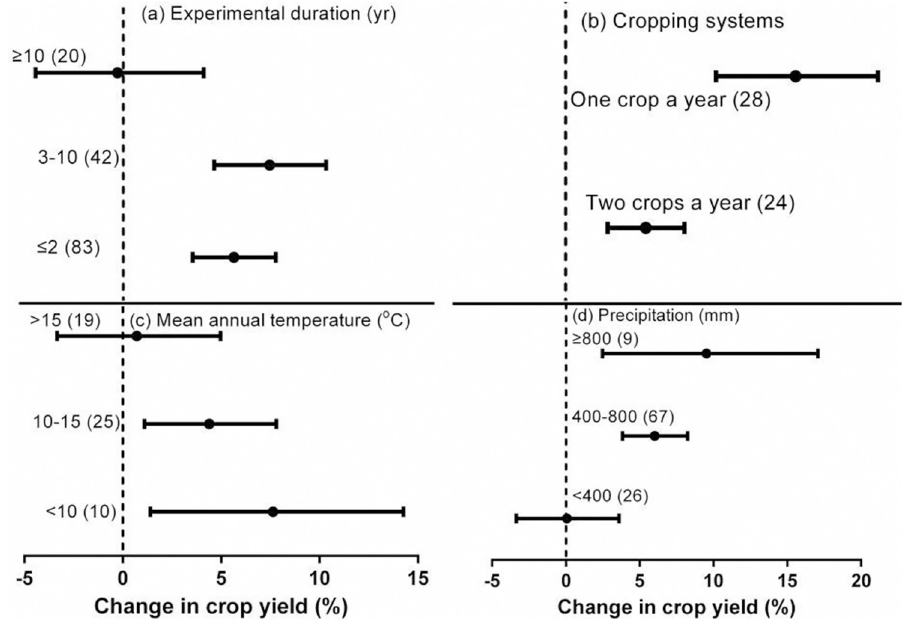
Fig 5. Effect of crop residue return on crop yield under different experimental duration (a) and cropping system types (b), mean annual temperature (c), and precipitation (d). Error bars represent the mean value ± 95% CI.